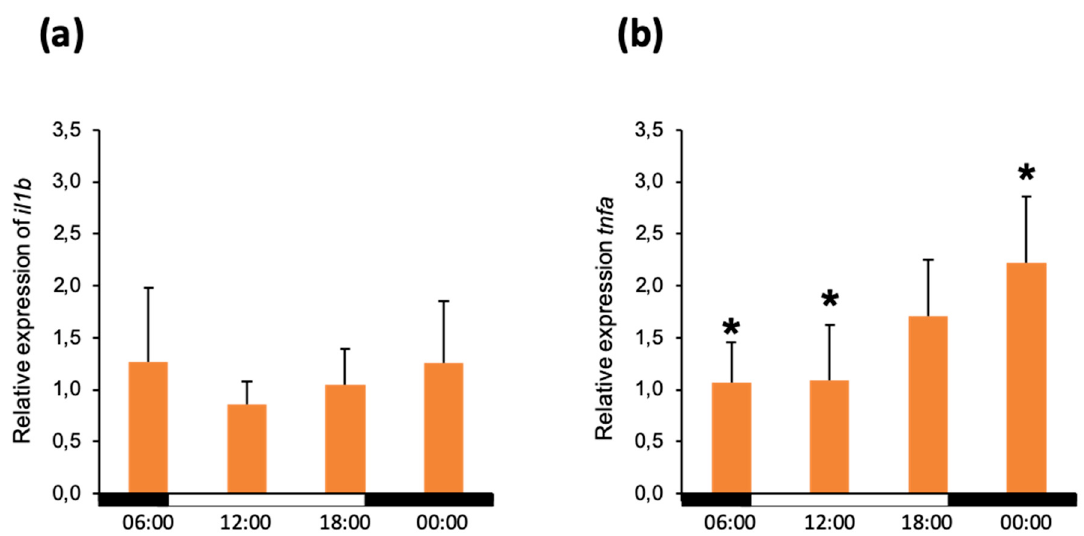
Figure 3. Relative expression of il1b ( a ) and tnfa ( b ) in the population of head kidney leukocytes following stimulation with inactivated A. salmonicida . Cells were incubated for 6 h prior the measurement. The data is presented as mean values with SD error bars. The statistical test used was one-way ANOVA with the Bonferroni post hoc test. p ≤ 0.1 and statistically significant differences are marked by asterisks (*). The white and black bars on the x-axis demonstrate the dark/light period.